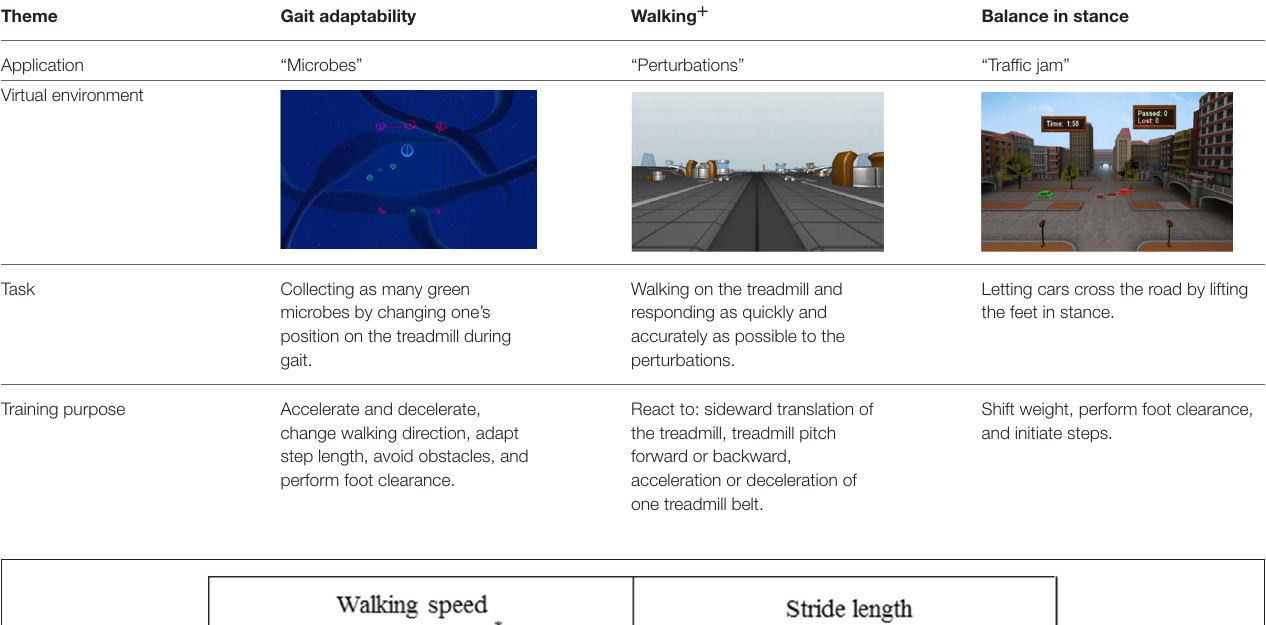
TABLE 2 | Most frequently performed applications on the GRAIL per